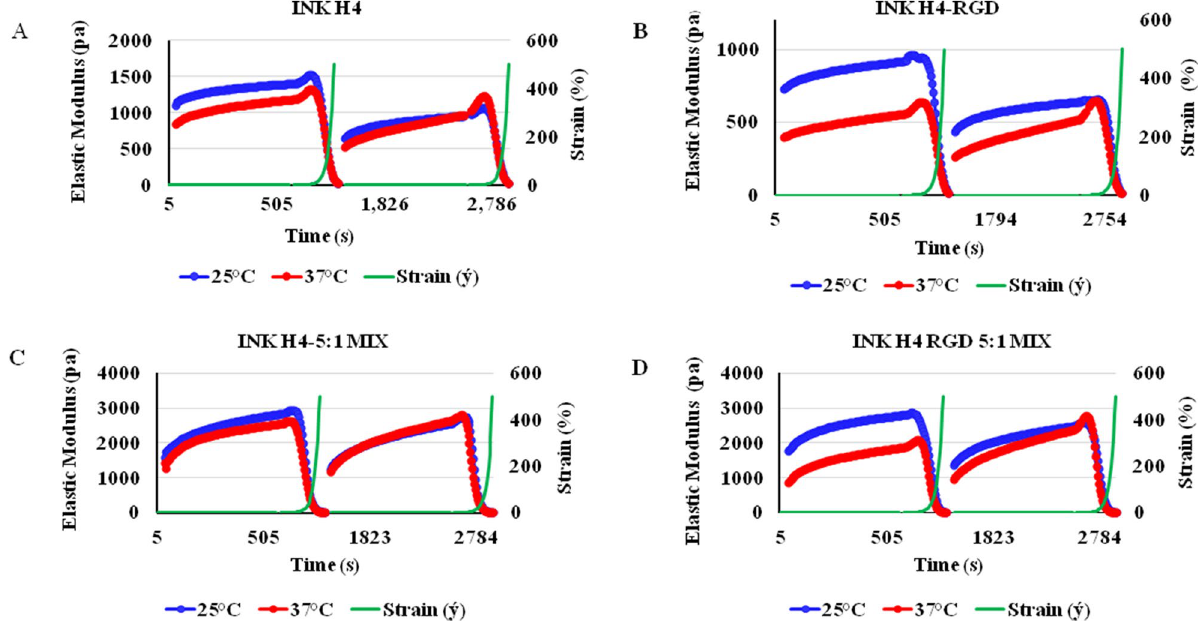
Figure 5. Shear-thinning and rapid shear recovery properties of Ink H4 and Ink H4-RGD by oscillation- amplitude sweep test. Two sets of the oscillatory amplitude sweep tests were performed for each bioink (0.1– 500% shear strain, 10 min each). Oscillation strain above the critical strain disrupts the network of the hydrogel, indicating shear thinning property. The initial G ′ of the second test indicated the rapid healing of the mechanical property after the first test. ( A ) Repeated shear-thinning and shear recovery properties of Ink H4 at both 25 °C and 37 °C; ( B ) Repeated shear-thinning and shear recovery properties of Ink H4-RGD at both 25 °C and 37 °C; ( C ) Repeated shear-thinning and shear recovery properties of Ink H4 5:1 mix (cross-linked) with cell culture media at both 25 °C and 37 °C; ( D ) Repeated shear-thinning and shear recovery properties of Ink H4-RGD 5:1 mix (cross-linked) with cell culture media at both 25 °C and 37 °C.